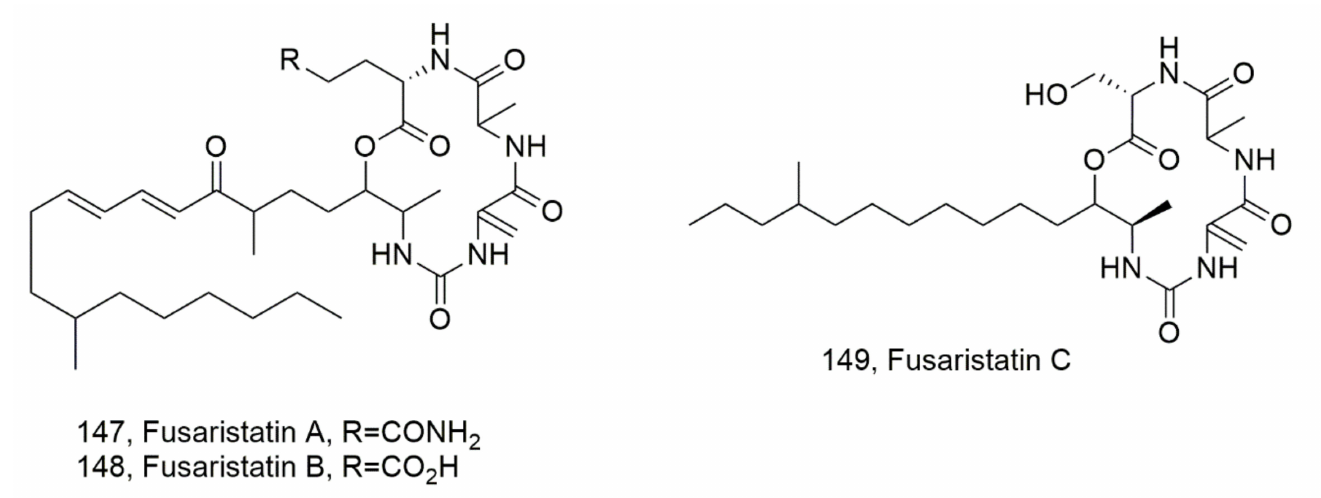
Figure 16. Structure of lipodepsipeptide produced by Fusarium sp. ( 147 and 148 ) and Pithomyces sp. ( 149